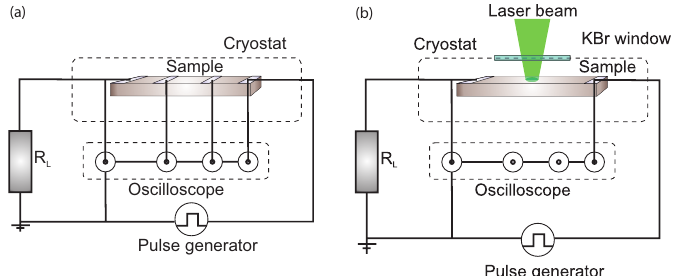
Figure 5. ( a ) For the time-resolved transport measurement either the four-point or two-point configuration was employed. It can be switched between the steady-state and the time-resolved transport measurement. The voltage pulses are created by an Avtech AV-1010 B of Hewlett-Packard HP 214B pulse generator. A Tektronix TDS 744A oscilloscope (input impedance 1 M Ω ) records the applied voltage U , the voltage drop across the inner contacts U 23 as well as the total current of the circuit by the voltage drop U L across the load resistor R L in series; ( b ) Schematic drawing of the photoconductivity setup. It consists of a pulse generator creating the voltage U at the sample, an oscilloscope, and a load resistor. R L is used to determine the current in the circuit. The frequency doubled Nd:YAG laser beam is focussed through the cryostat window. The beam diameter is approximately 0.6 mm, the laser intensity ranged up to 5